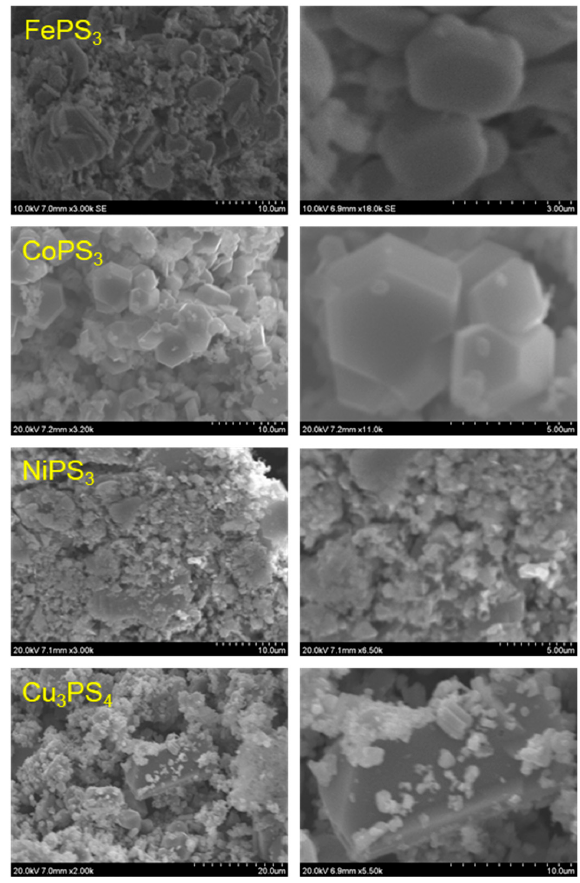
Figure 4. SEM images of M-P-S materials synthesized from metal halides and (P + S) at 500 °C. The right images are higher magnification images of the products shown in the left images.